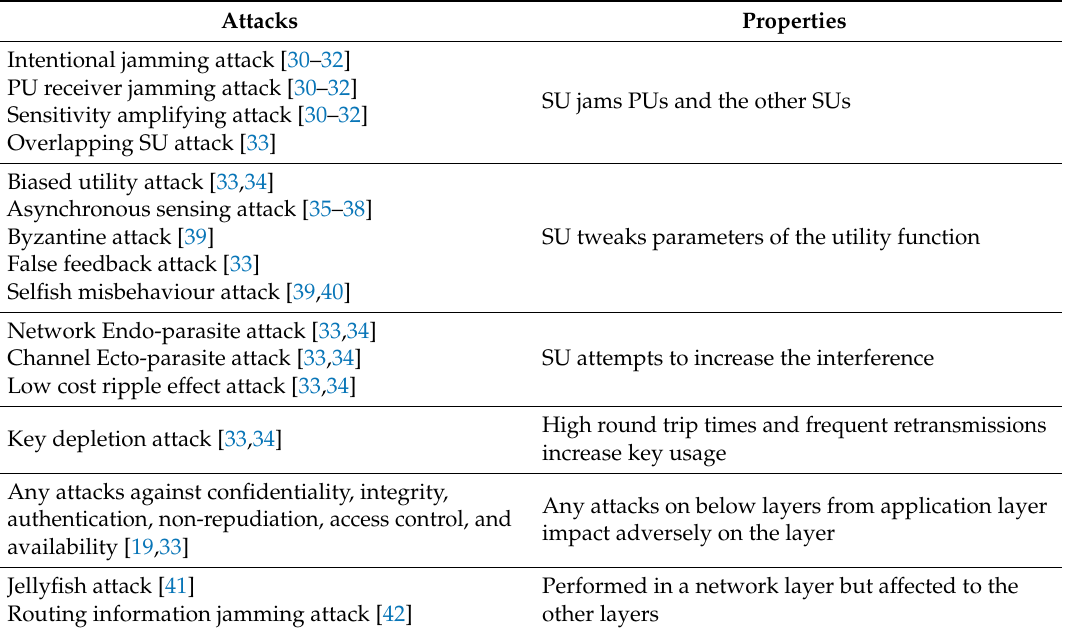
Table 1. CRN attacks and